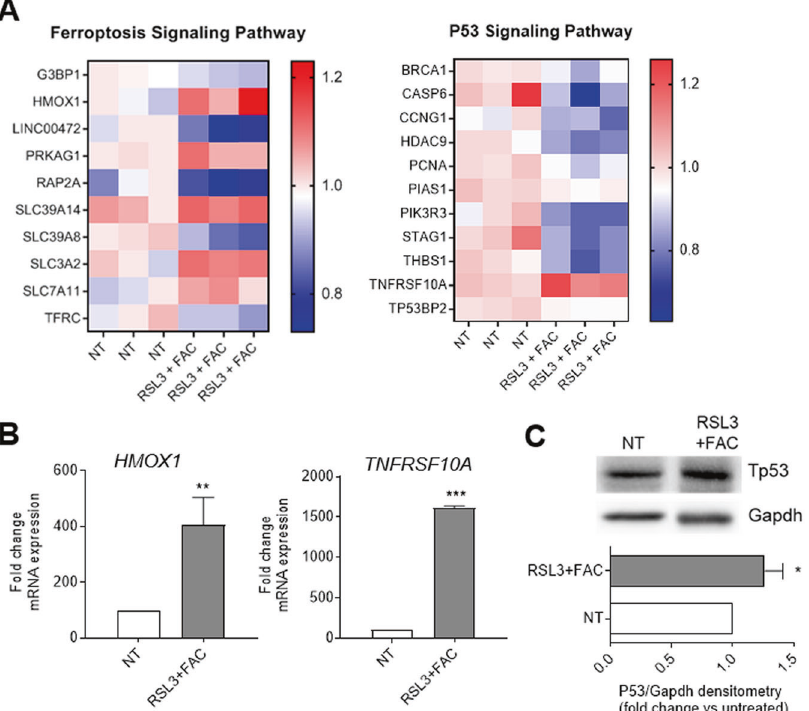
Fig. 3 RSL3 + FAC treatment impact on ferroptosis and P53 molecular pathways. A Heatmaps of modulated pathways showing the most differentially expressed genes in DU145 cells treated with 0.5 μ M RSL3 + 100 μ M FAC for 12 h. B , C The gene expression modulation of HMOX1 and TNFRSF10A , respectively of the ferroptosis and P53 pathway, was con fi rmed by RT-qPCR analyzes and expressed as % fold change over the not treated (NT) cells ( B ), while Western blot analysis revealed an increase of Tp53 protein. Gapdh was used for normalization ( C ). Data are the mean ± SEM of at least 3 experiments ( *p < 0.05 , **p < 0.01 , ***p <